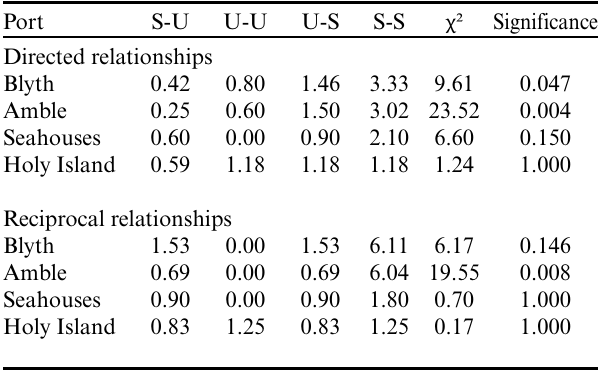
Table 3 . Patterns of information-sharing between “successful” (S) and “unsuccessful” (U) fishers. For example, S-U indicates successful fishers sharing information with unsuccessful fishers. Fishers denoted S are perceived as successful by at least one of their peers. Numbers in cells represent the ratio of observed to expected information-sharing ties. Values greater than 1 indicate ties observed more frequently than expected. Significance values are based on 1000